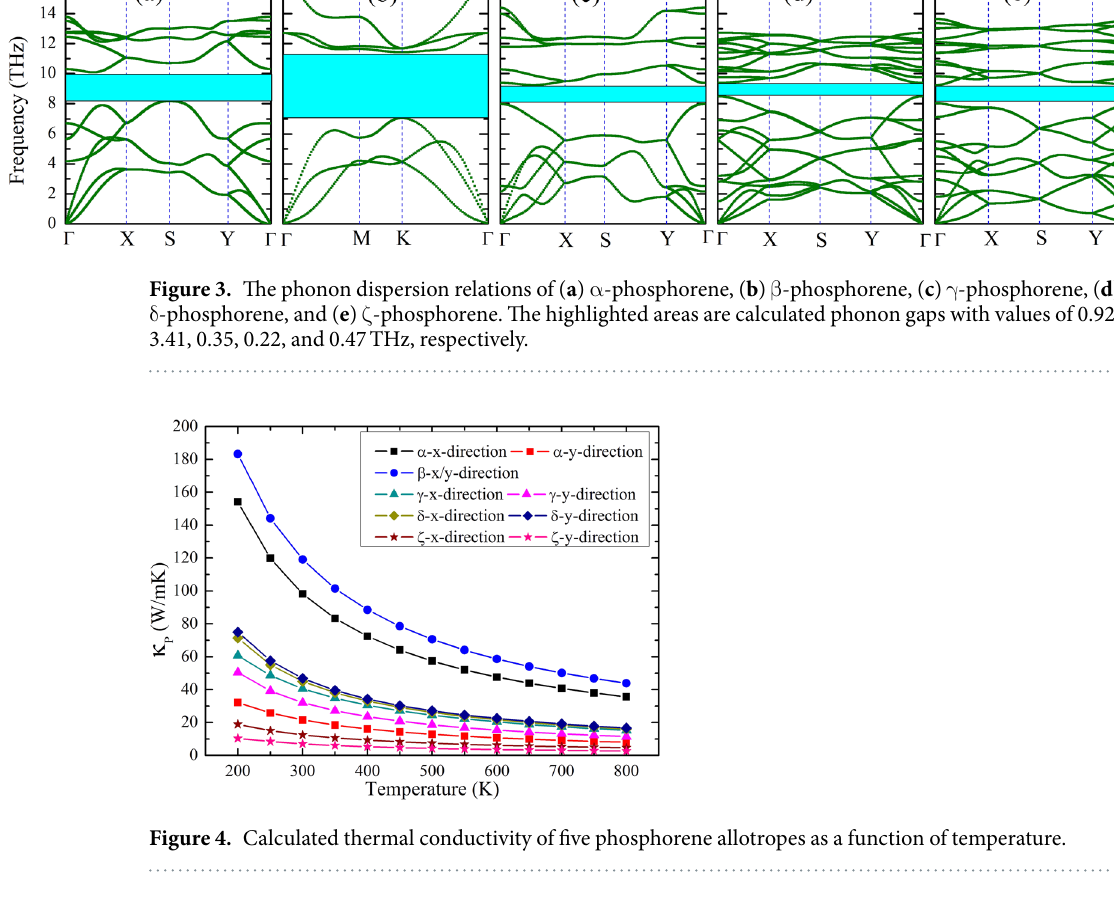
phase α β γ δ ζ